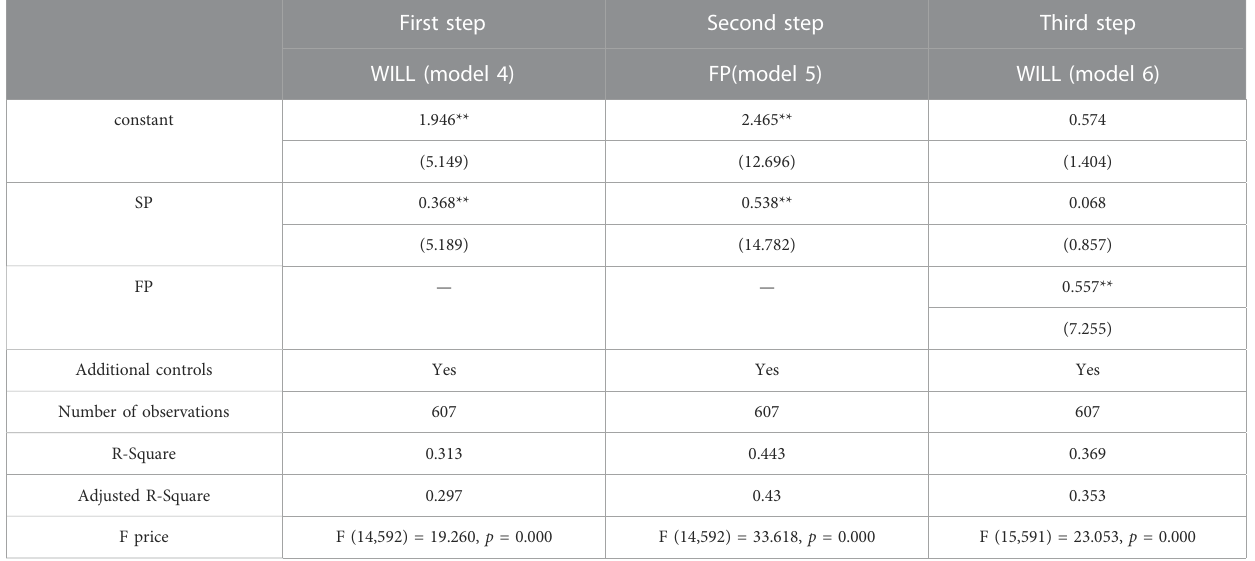
TABLE 4 Progressive regression results of the overall perceived mediation effect among farmers.